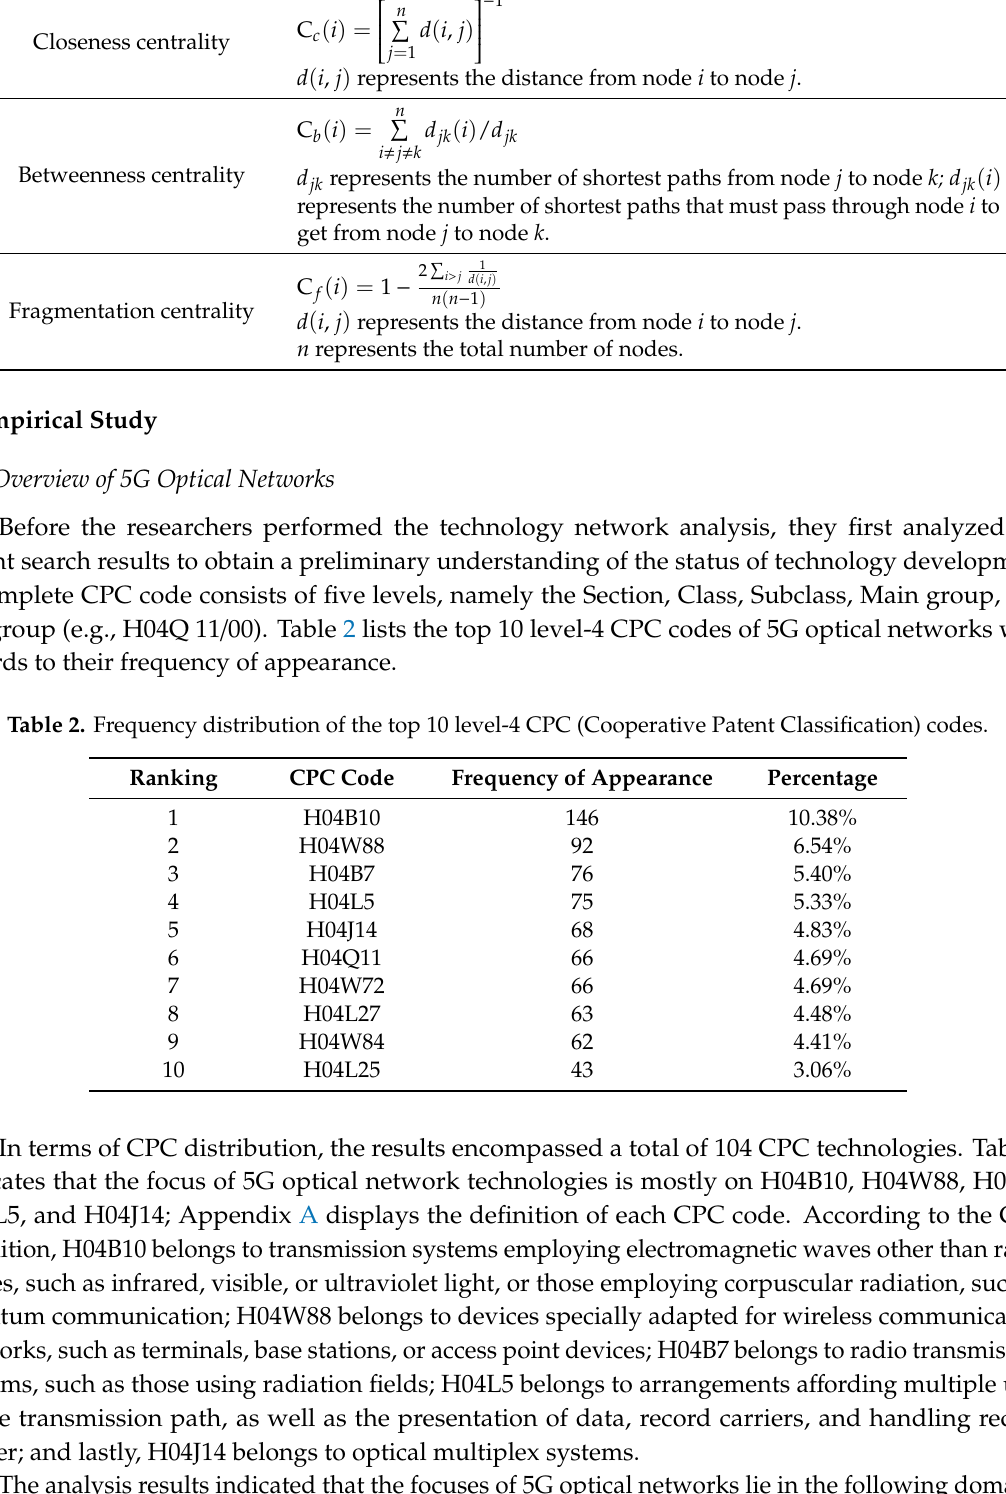
Table 1. Methods used for measuring the centrality of the technology network. Indicator Formula − 1     n (cid:80) d ( i , j ) C c ( i ) = Closeness centrality j = 1 d ( i , j ) represents the distance from node i to node j . n (cid:80) d jk ( i ) / d jk C b ( i ) = i (cid:44) j (cid:44) k Betweenness centrality d jk represents the number of shortest paths from node j to node k; d jk ( i ) represents the number of shortest paths that must pass through node i to get from node j to node k . 2 (cid:80) i > j 1 d ( i , j ) C f ( i ) = 1 − n ( n − 1 ) Fragmentation centrality d ( i , j ) represents the distance from node i to node j . n represents the total number of nodes.